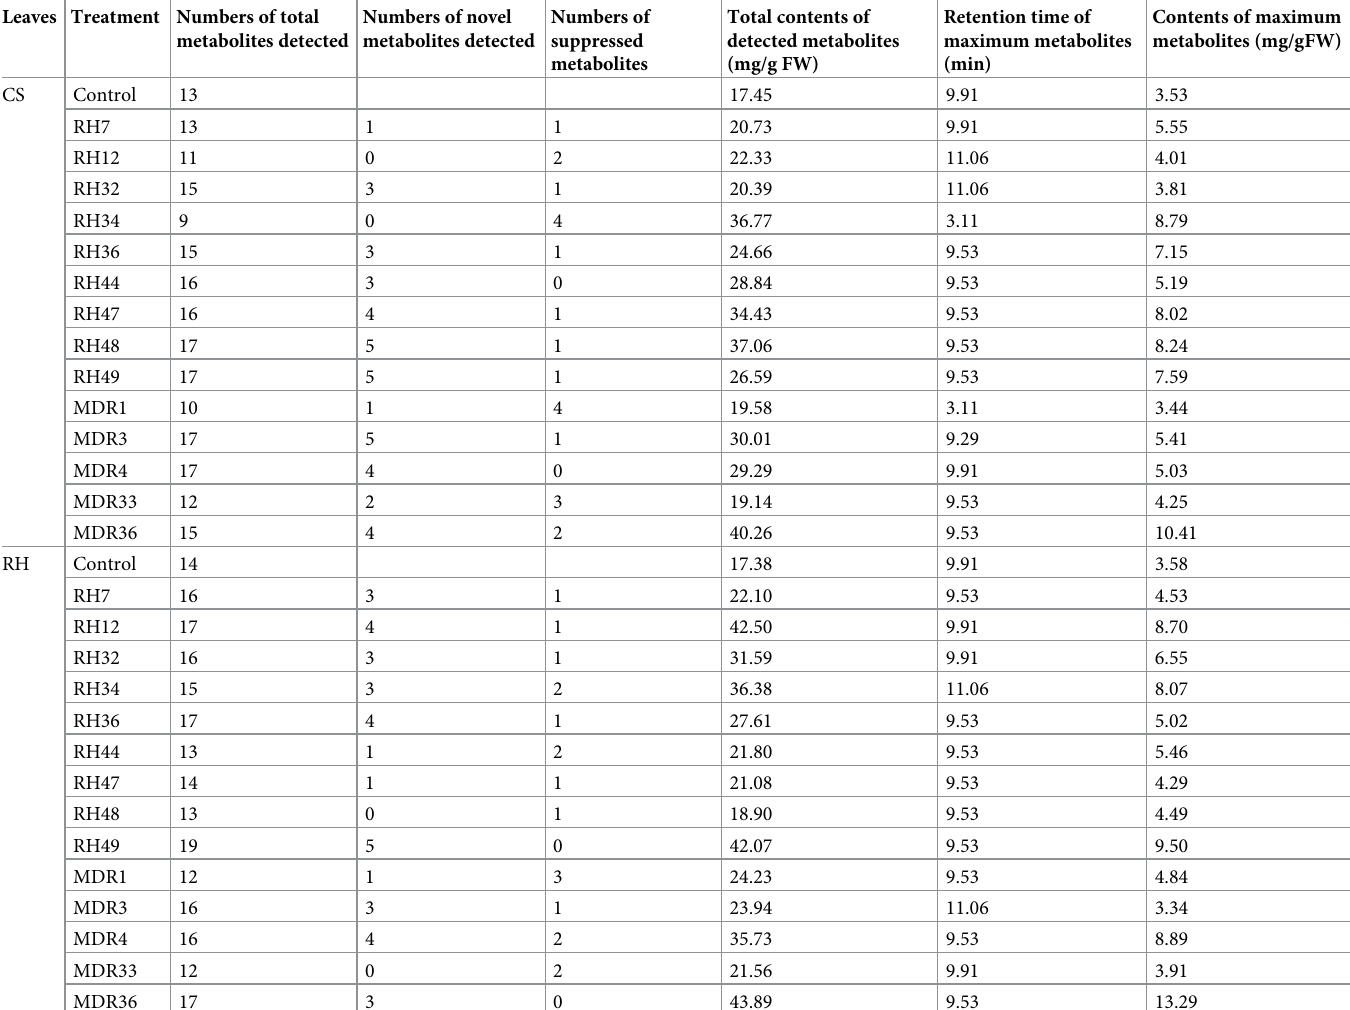
Table 2. The impacts of endophytic fungal infectionon special parameters of metabolites. Leaves Treatment Numbers of total Numbers of novel Numbers of metabolites detected metabolites detected